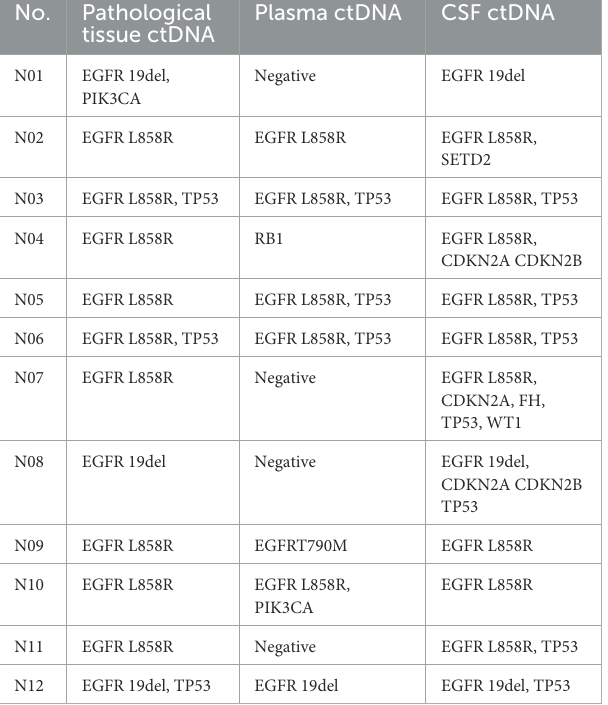
TABLE 4 Results of pathological tissue ctDNA, plasma ctDNA and CSF ctDNA of 12 patients with MC.